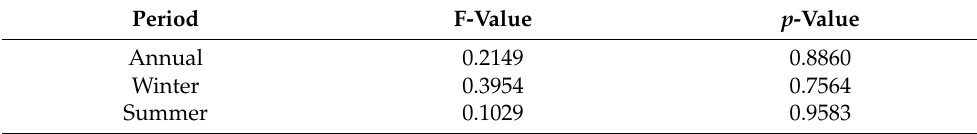
Table 10. Summary of the output ANOVA and Tukey–Kramer tests for future extreme Dm